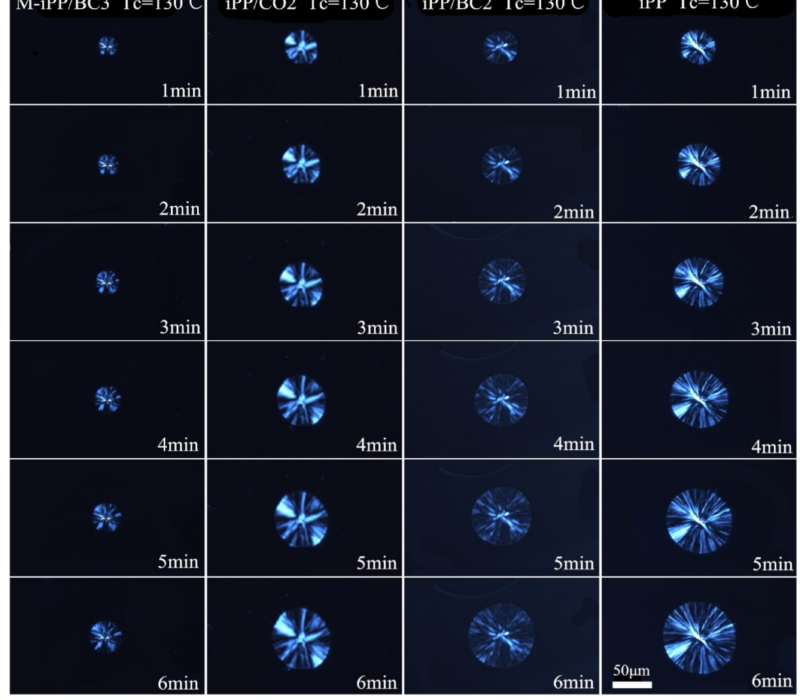
Figure 5. The POM images of the iPP/BC composites at 130 ◦